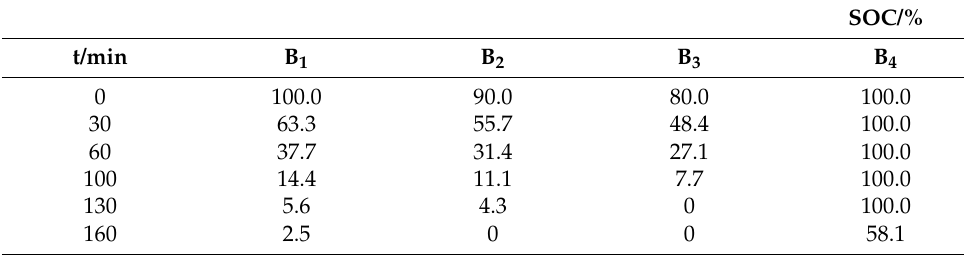
Table 3. Traditional redundant battery management algorithm.